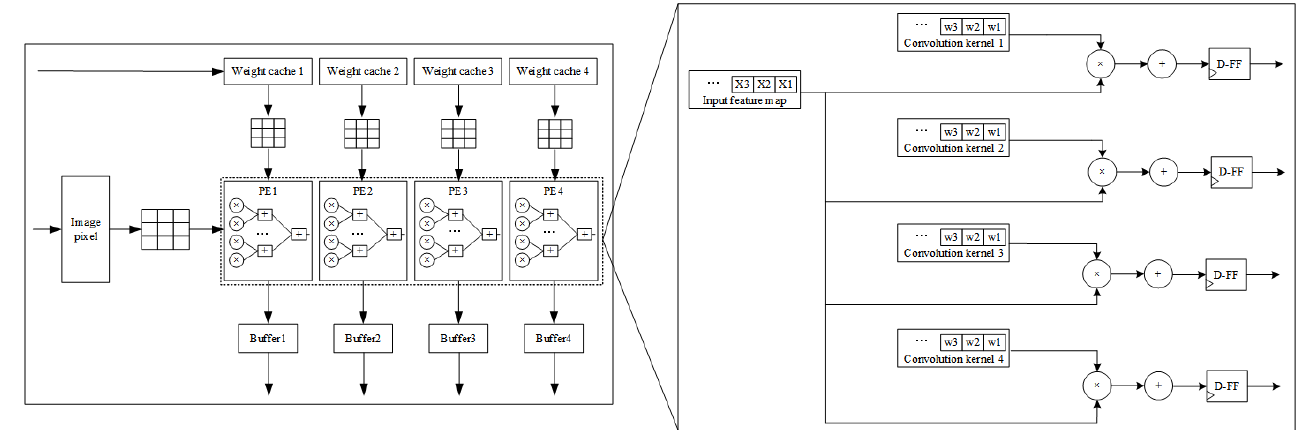
Figure 9. Parallel convolutional architecture design.